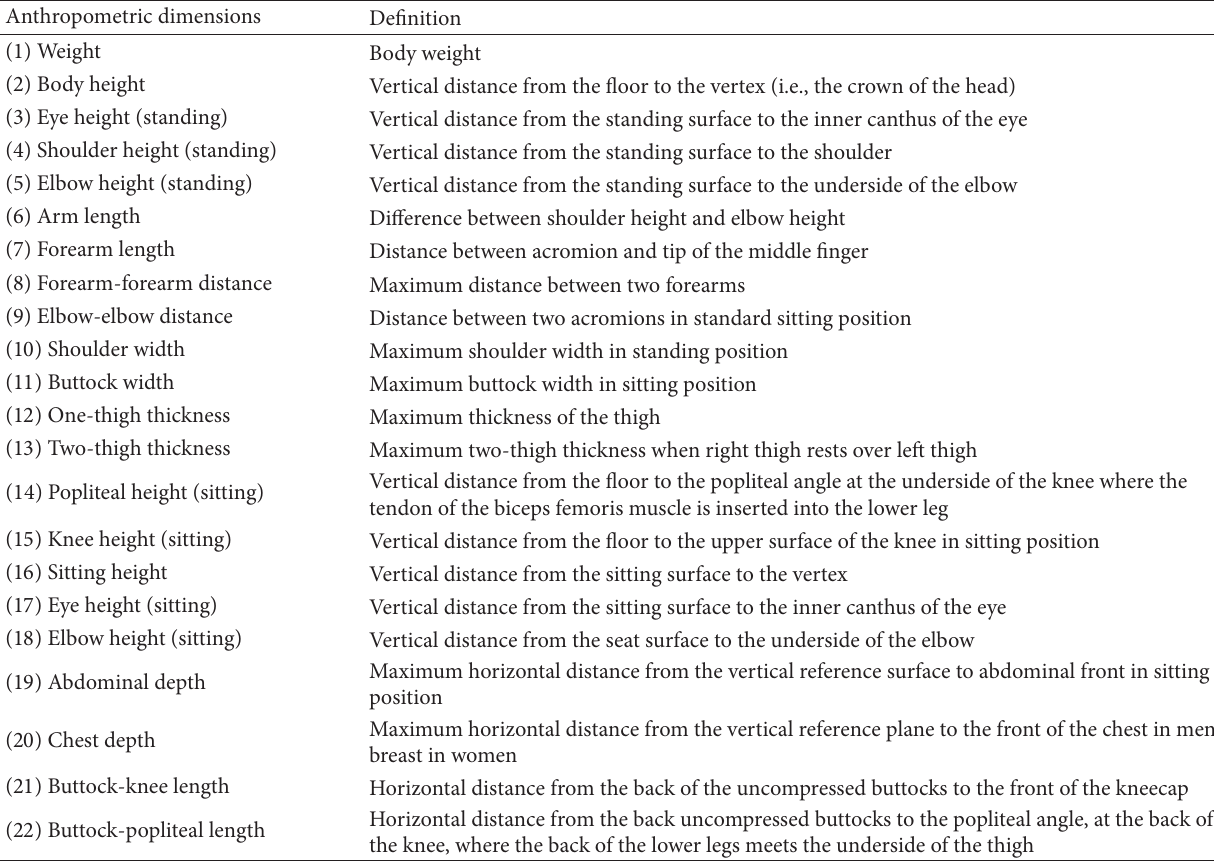
Table 1: Definition of anthropometric data.